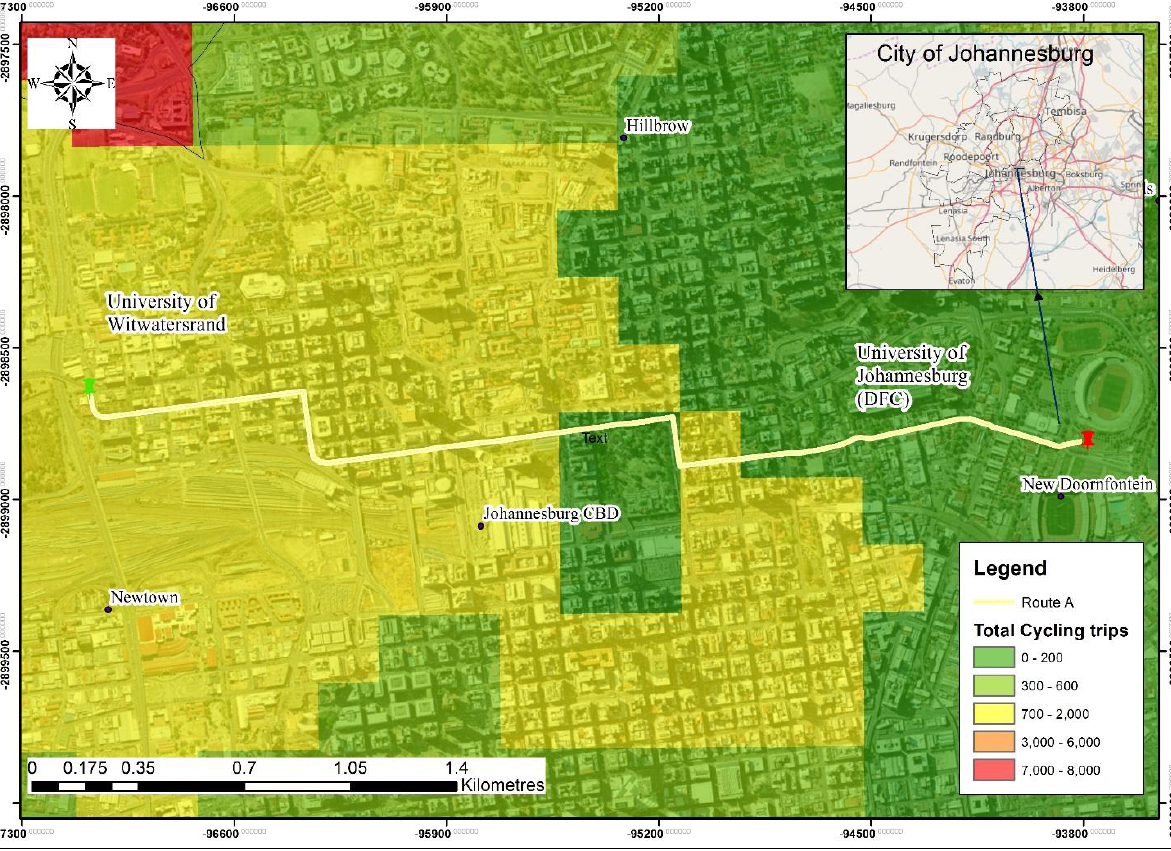
Figure 6: Route A overlaid with Total cycling trips recorded on Strava